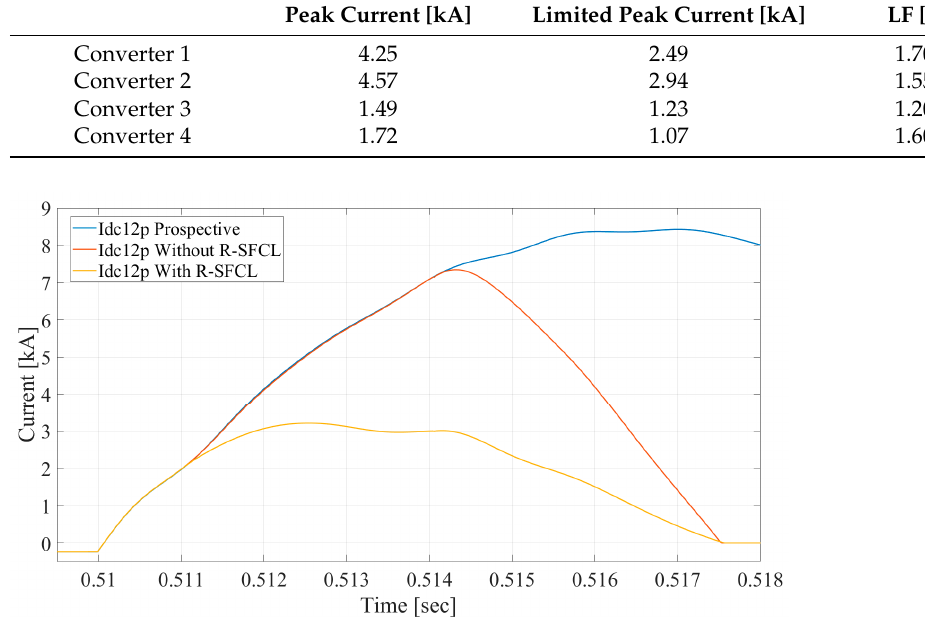
Figure 24. Link 12 positive pole fault current for pole-to-ground fault, prospective, with M-DCCB, with M-DCCB and